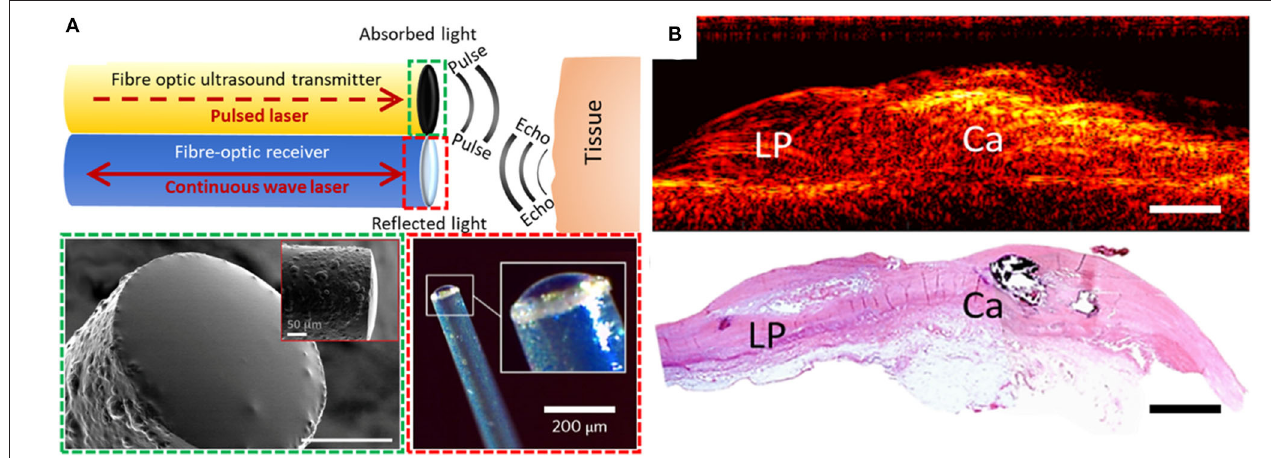
FIGURE 1 | (A) Generation and reception of OpUS. The schematic (top) includes both a transmitter and a receiver. Lower-left inset (dashed green box): scanning electron microscopy image of the transmitter fiber-tip coated with nanocomposite (scale bar: 50 µ m) ( 15). Lower-right inset (dashed red box): optical microscopy of the fiber-optic receiver (19). (B) 2D longitudinal M-mode OpUS imaging of ex-vivo human coronary artery tissue with a lipid pool (LP), calcification (Ca), and corresponding histology (haematoxylin and eosin staining) (scale bars: